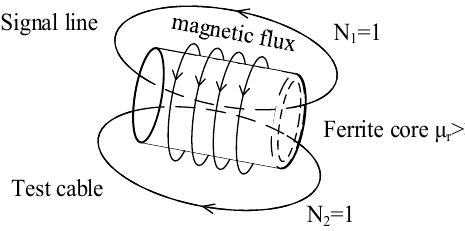
Figure 5. Inductive coupling of two windings.